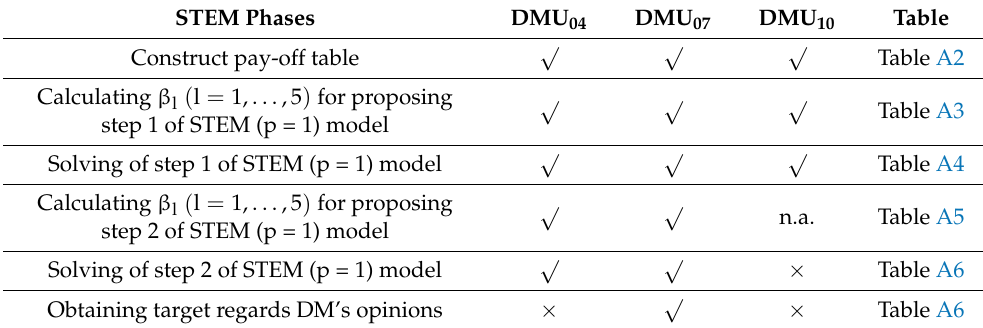
Table A7. Applying the second interactive stage for three considered DMUs (the second case study). STEM Phases Construct pay-off table Calculating β l ( l = 1, . . . ,5 ) for proposing step 1 of STEM (p = 1) model Solving of step 1 of STEM (p = 1) model Calculating β l ( l = 1, . . . ,5 ) for proposing step 2 of STEM (p = 1) model Solving of step 2 of STEM (p = 1) model Obtaining target regards DM’s opinions × Target finding of non-radial FDH models 12 and 13 for DMU 07 in the second case study